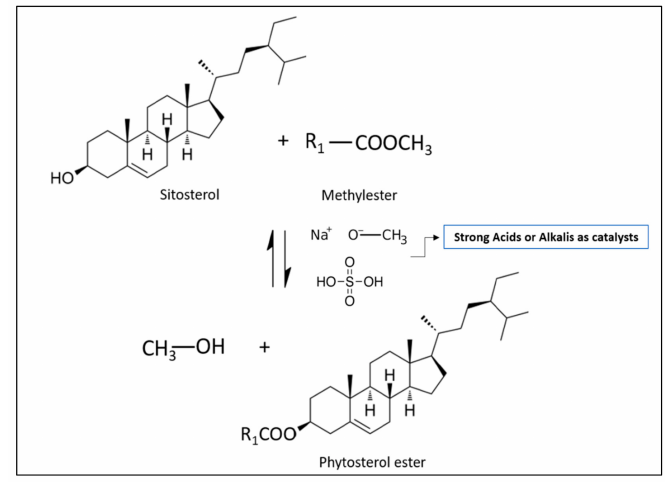
Figure 3. Scheme of phytosterol esters’